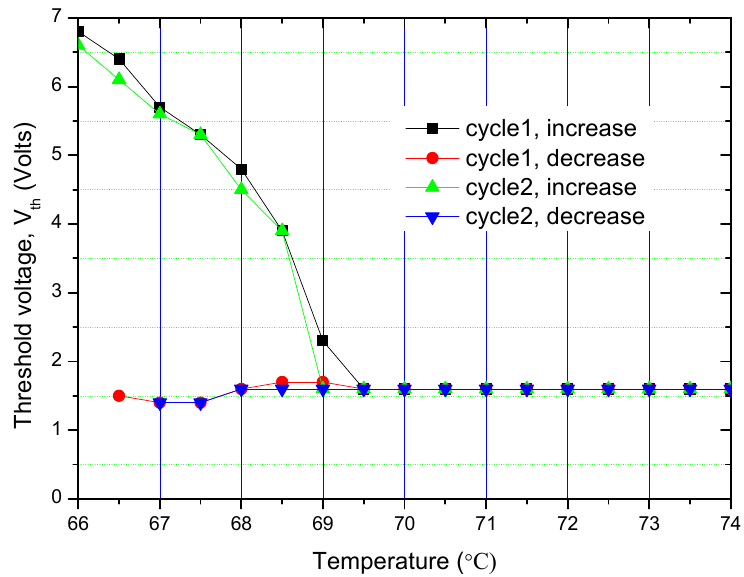
Figure 7. The threshold voltage (V th ) plotted as a function of temperature for the Fréedericksz transition. First cycle: V th for the square wave amplitude increasing is plotted as black squares, V th for the amplitude decreasing is plotted as red circles. Second cycle: V th for both increasing and decreasing amplitudes of the square waveform are shown by green ‘up’ and blue ‘down’ triangles, respectively.